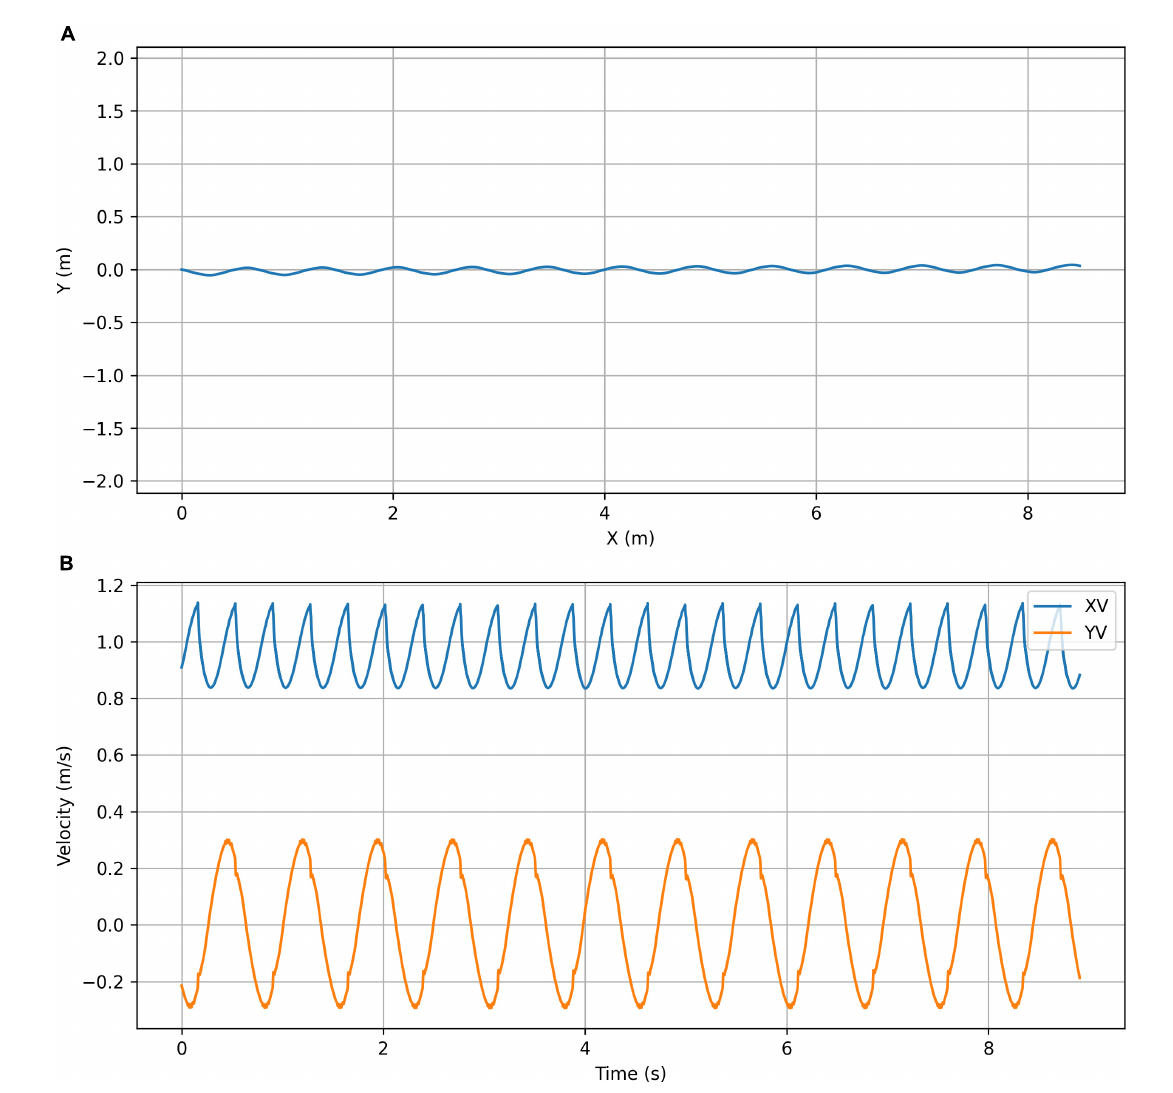
FIGURE10 Optimized for efficiency simulation plots. (A) Trajectory plot showing the top view of the path taken by the center of mass of the chimpanzee’s torso. (B) Velocity plot showing the X (forward) velocity and Y (lateral) velocity of the center of mass of the chimpanzee’s